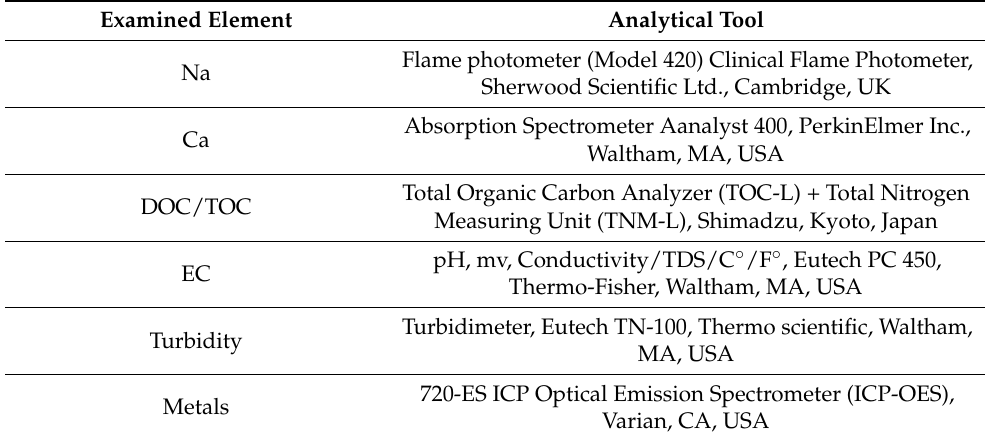
Table 2. Examined elements in the water samples and analytical